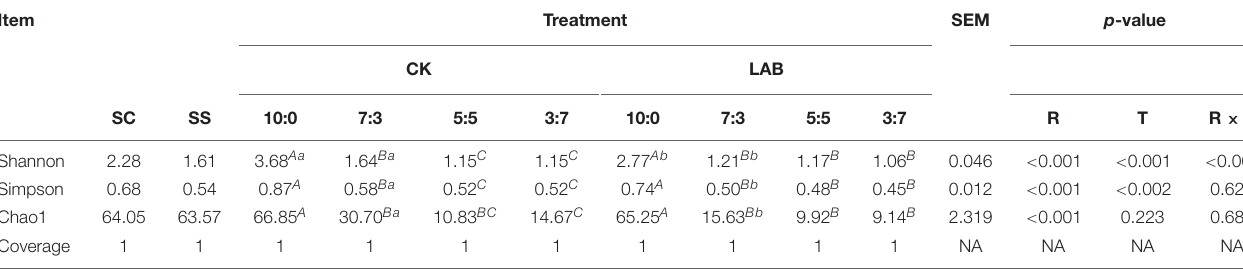
TABLE 2 | Alpha diversity of bacterial diversity of SC-SS silage. Item Treatment SEM p -value